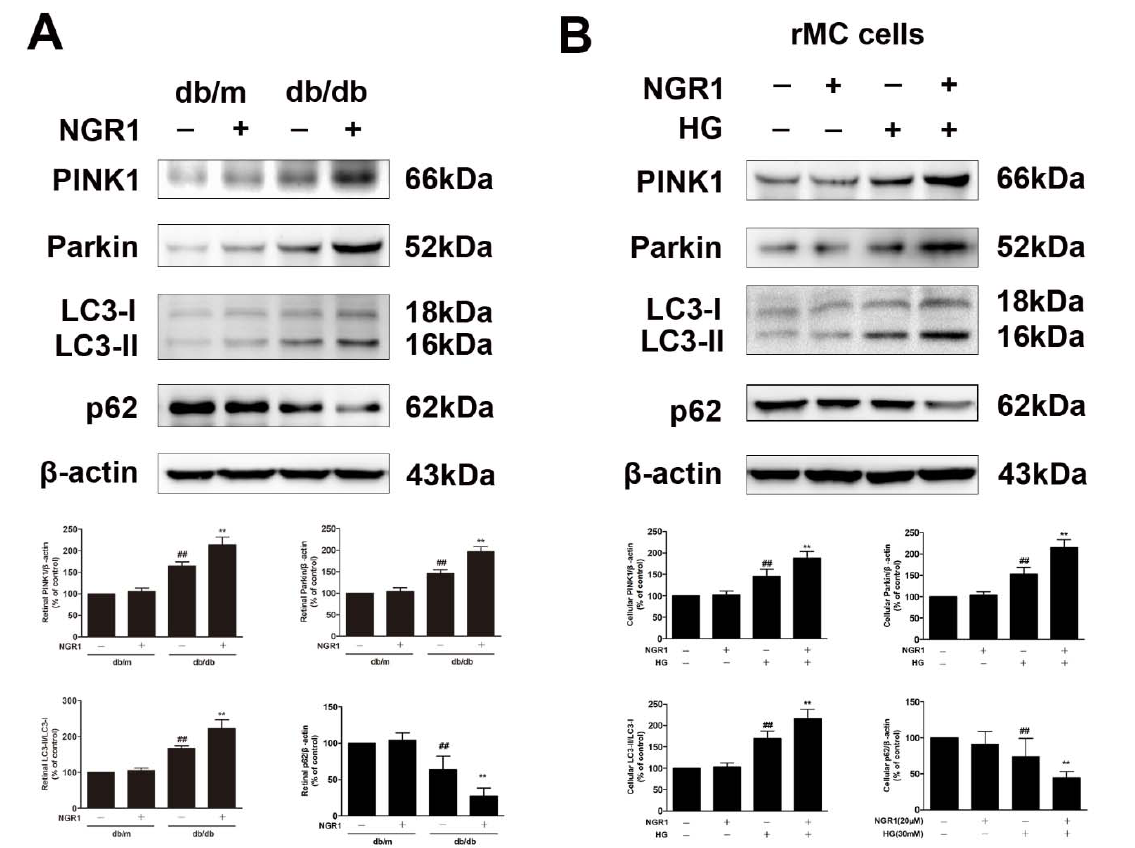
Figure 9. Effects of NGR1 pre-treatment on the expression level of mitophagy proteins in HG-induced rMC1 cells and in diabetic db/db mice with diabetic retinopathy. ( A ) PINK1, Parkin, LC3-II/LC3-I, and p62/SQSTM1 expression in the retina of db/db mice was determined by Western blotting. ( B ) The expression of PINK1, Parkin, LC3-II/LC3-I, and p62/SQSTM1 in HG-induced rMC1 cells was determined by western blotting. The results are expressed as the means ± SD (n = 10). Two groups were analysed by unpaired two-tailed Student’s t tests, and multiple groups were analysed by one-way analysis of variance (ANOVA); ## indicates significant difference from the control cells or db/m mice ( p < 0.01). ** indicates a significant difference from HG treatment or db/db mice ( p < 0.01). ## indicates a significant difference from control cells or db/m mice ( p < 0.01). ** indicates a significant difference from HG treatment or db/db mice ( p < 0.01). (+), treatment with HG or NGR1; ( − ), treatment without HG or NGR1.